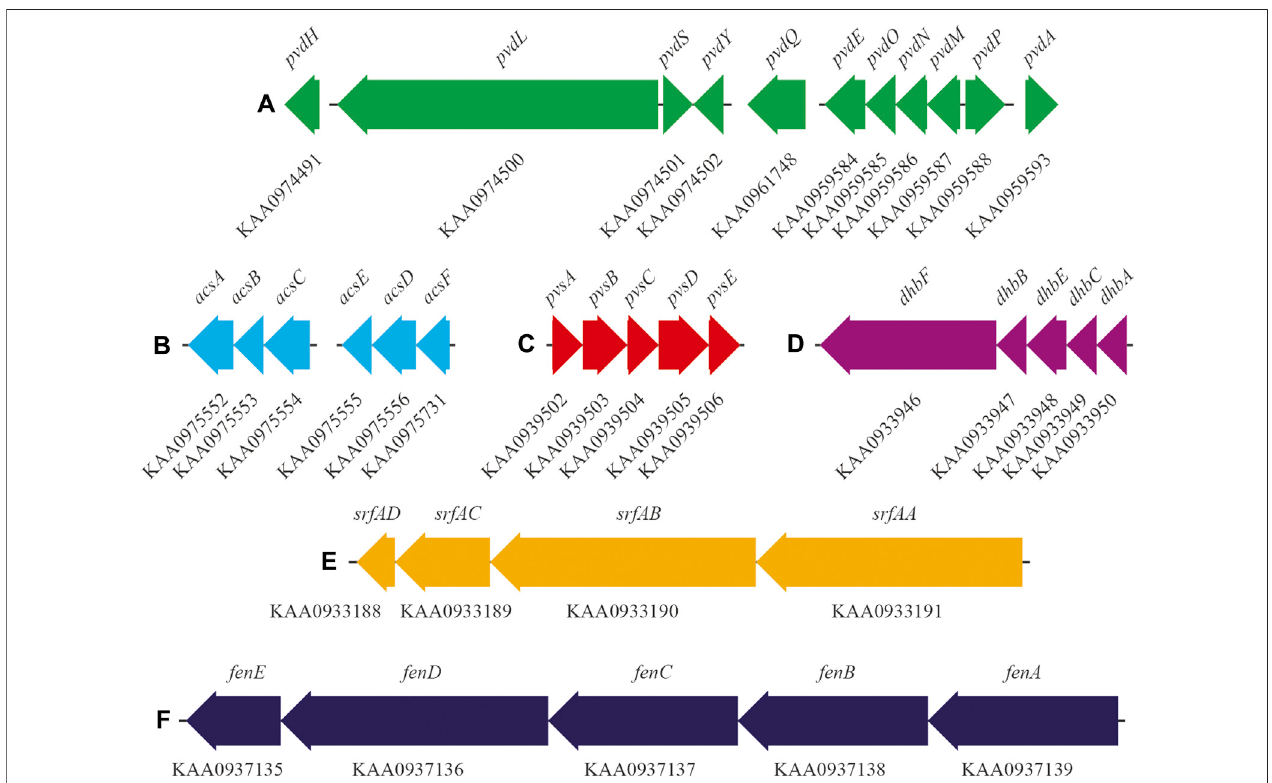
FIGURE 2 | Gene clusters responsible for the biosynthesis of siderophores, i.e.,: (A) pyoverdine and (B) achromobactin of Pseudomonas sp. ANT_H12B; (C) vibrioferrin of Psychrobacter sp. ANT_H59; (D) bacillibactin of Bacillus sp. ANT_WA51 and biosurfactants, i.e.,: (E) surfactin and (F) fengycin of ANT_WA51. Gene names and thair GenBank accession numbers are displayed above and under the arrows,